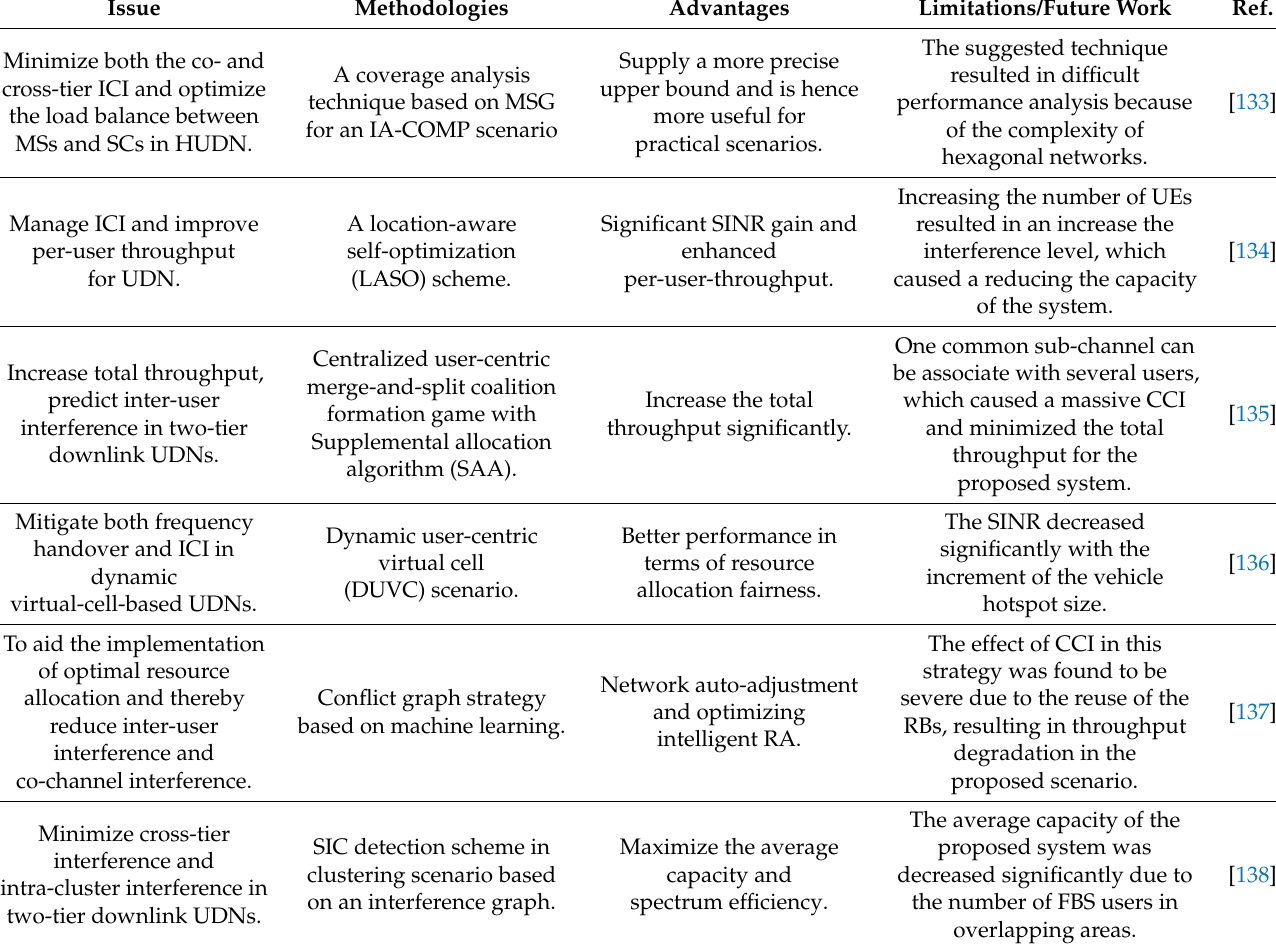
Table 4. The summary of related works of UDNs in the